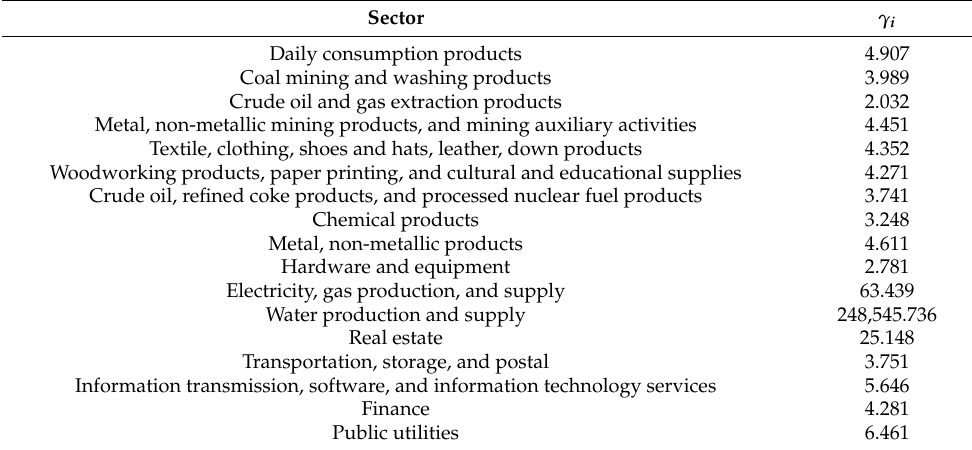
Table A6. The results of calibration of γ i .